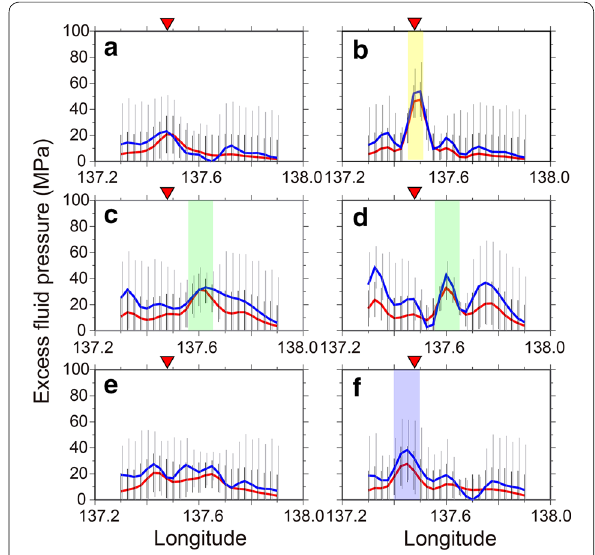
Fig. 5 FMT analysis considering the estimation errors of the stress fields. The profiles in ( a – f ) are displayed in the same way as in Fig. 3. The red and blue lines denote the pore-fluid pressures that did not and did incorporate the estimation errors of the stress field (in “FMT analysis around Mt. Ontake” and “Pore-fluid pressure drives microseis- mic swarm activity” sections), respectively. The black and light gray vertical lines represent the estimation errors (the 67% confidence region) for the analysis in “FMT analysis around Mt. Ontake” and “Pore- fluid pressure drives microseismic swarm activity” sections, respec- tively. The yellow , green , and blue shaded zones denote the region B1, B2, and B3, respectively. The red inverse triangles are the same as those in Fig.